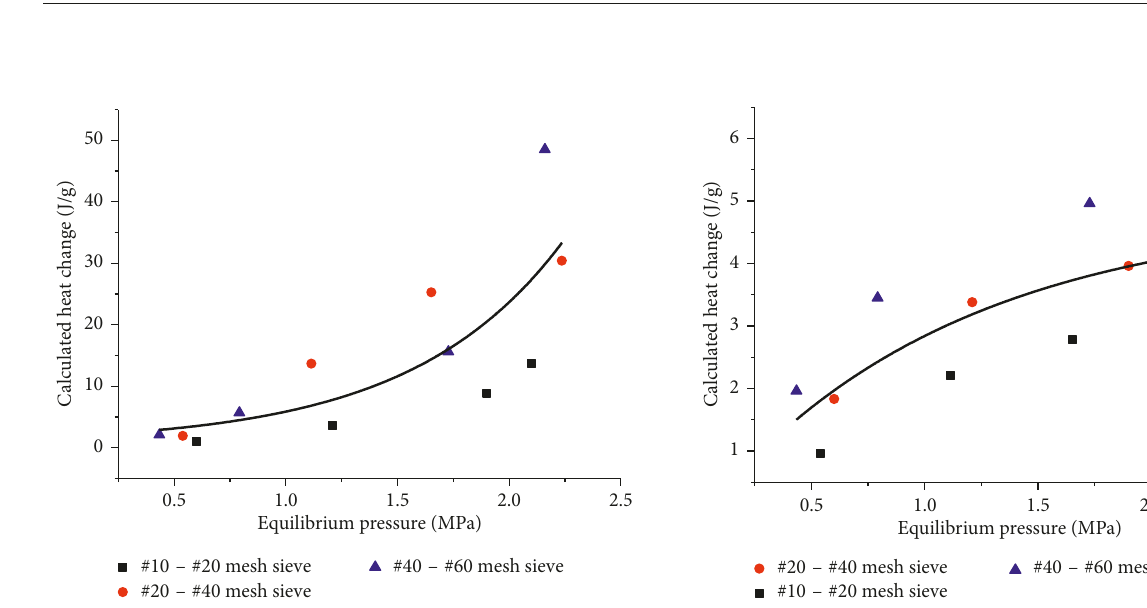
Figure 2: Theoretical desorption heat values of 8# Malan coal. Figure 3: Measured desorption heat values of 8# Malan